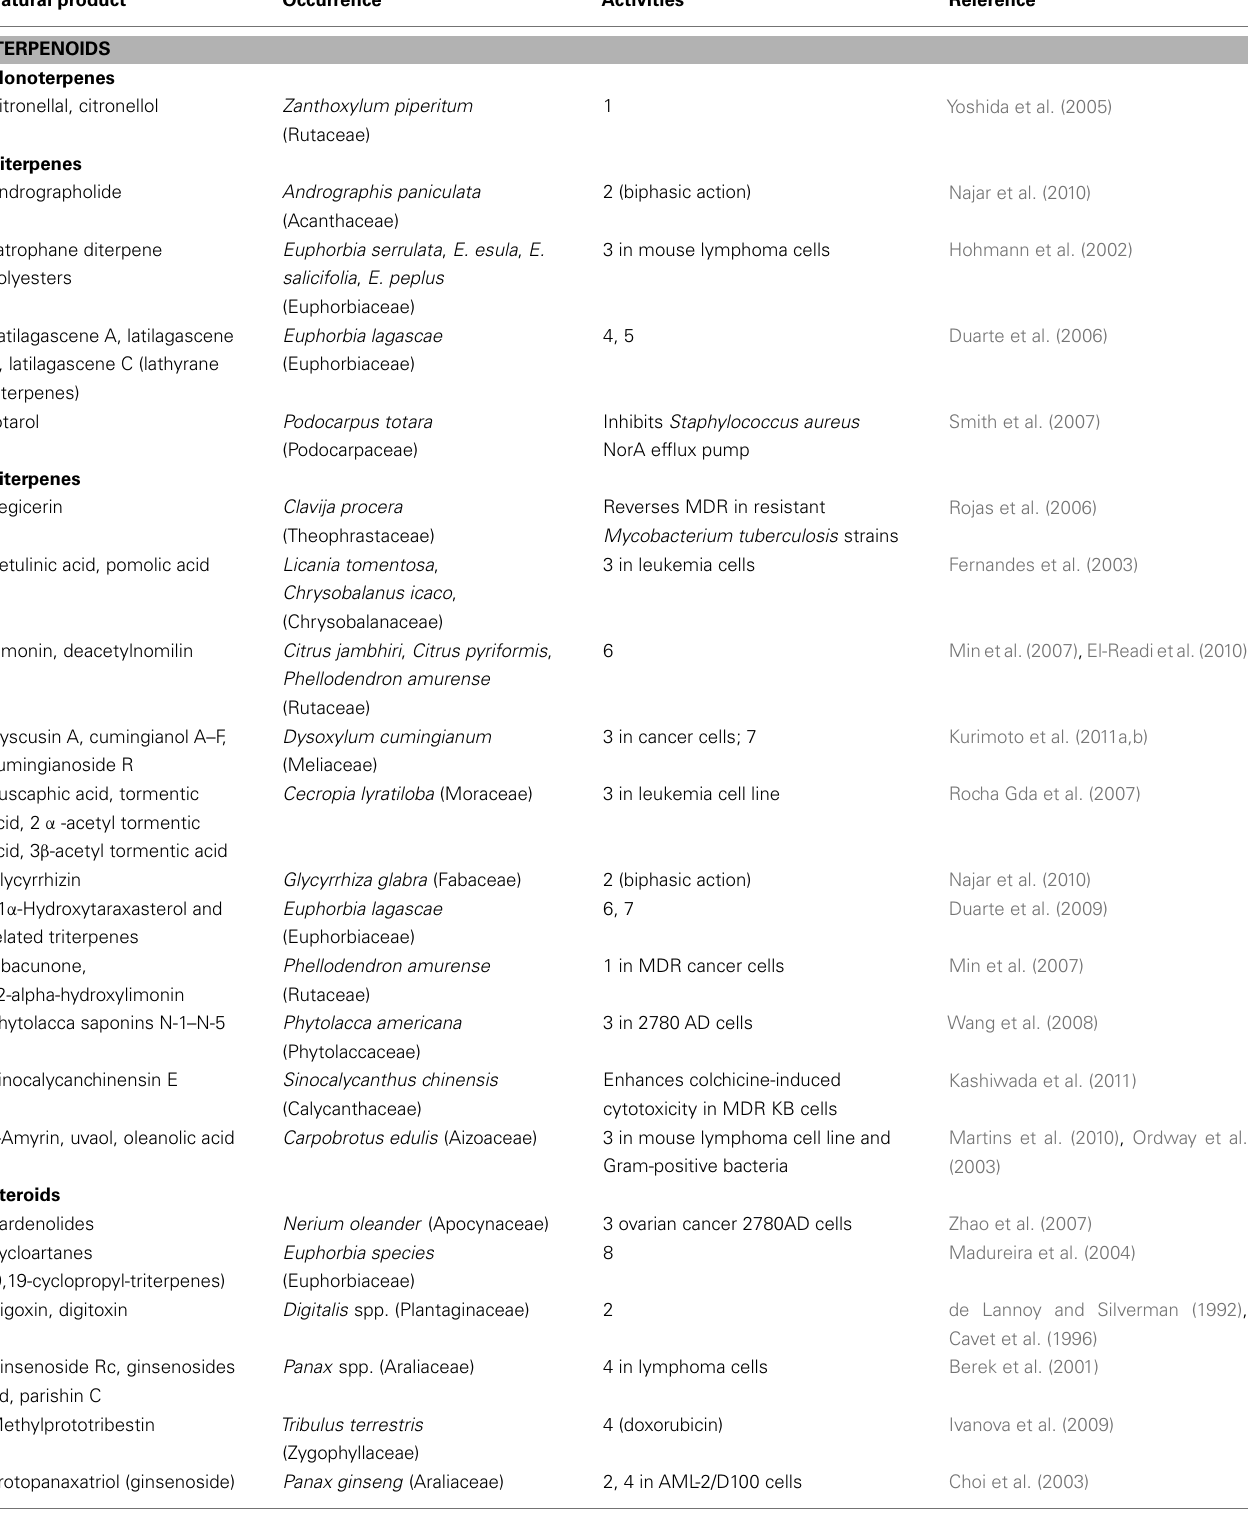
Table 2 | Secondary metabolites from plants that can inhibit P-gp, MRP1, BCRP, bacterial, and fungalABC